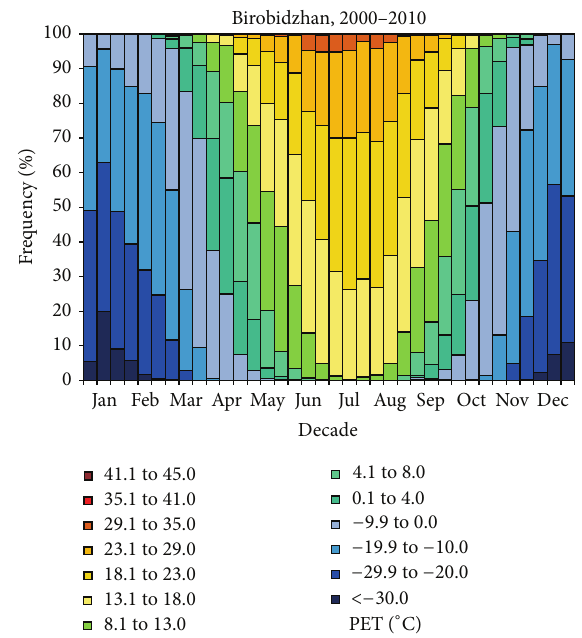
Figure 3: Mean frequency distribution of PET values in Biro- bidzhan, zone 1, during the year divided into 10-day intervals (decades) for the period